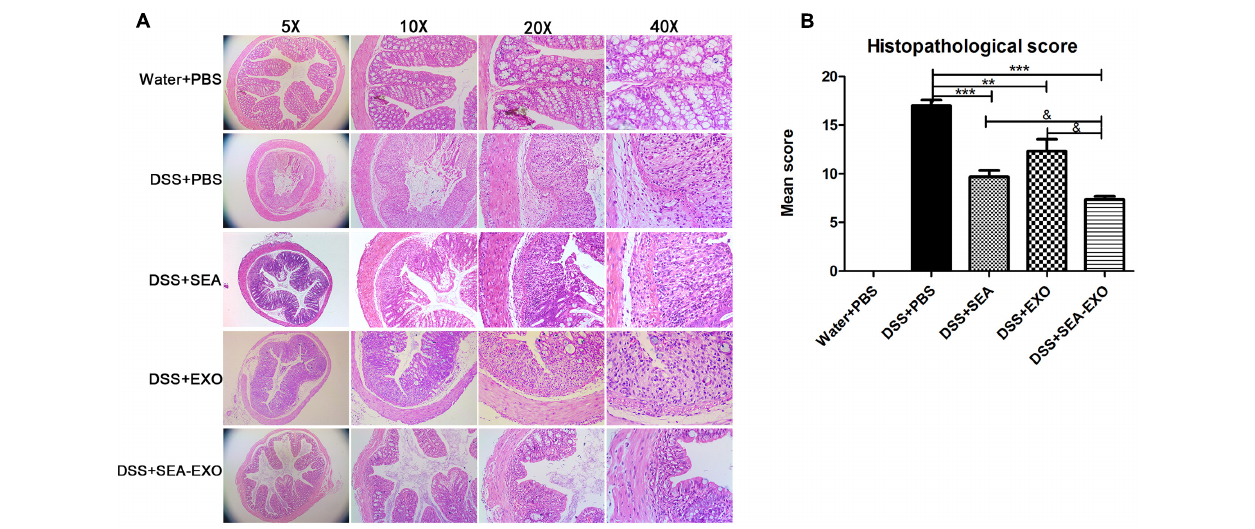
FIGURE 4 | Histopathological changes in the colons of acute DSS-induced colitis mice treated with exosomes. (A) Colon tissue samples were examined using H&E staining (5 × , 10 × , 20 × , and 40 × ). (B) Histopathological scores of colon tissue samples. Statistical analyses of multiple groups were performed using a one-way